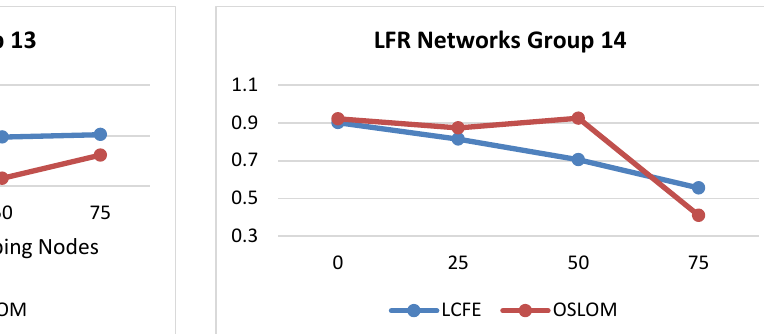
Fig. 15. NMI score comparison for LCFE and OSLOM for thirteenth group of LFR Networks with number of overlapping nodes ranging from 0 to 75